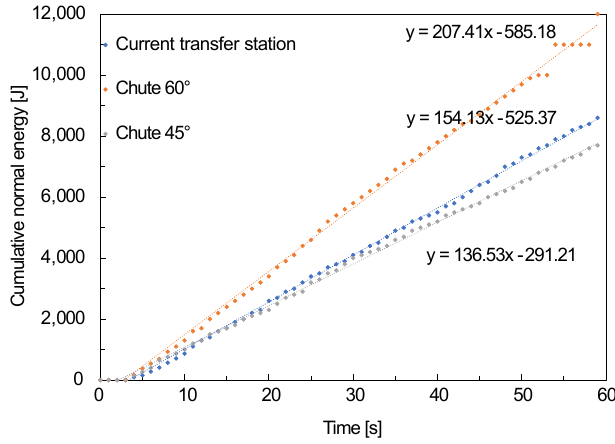
Figure 12. Total cumulative normal energy absorbed by the belt during collisions with the material for a capacity of 300 Mg/h.